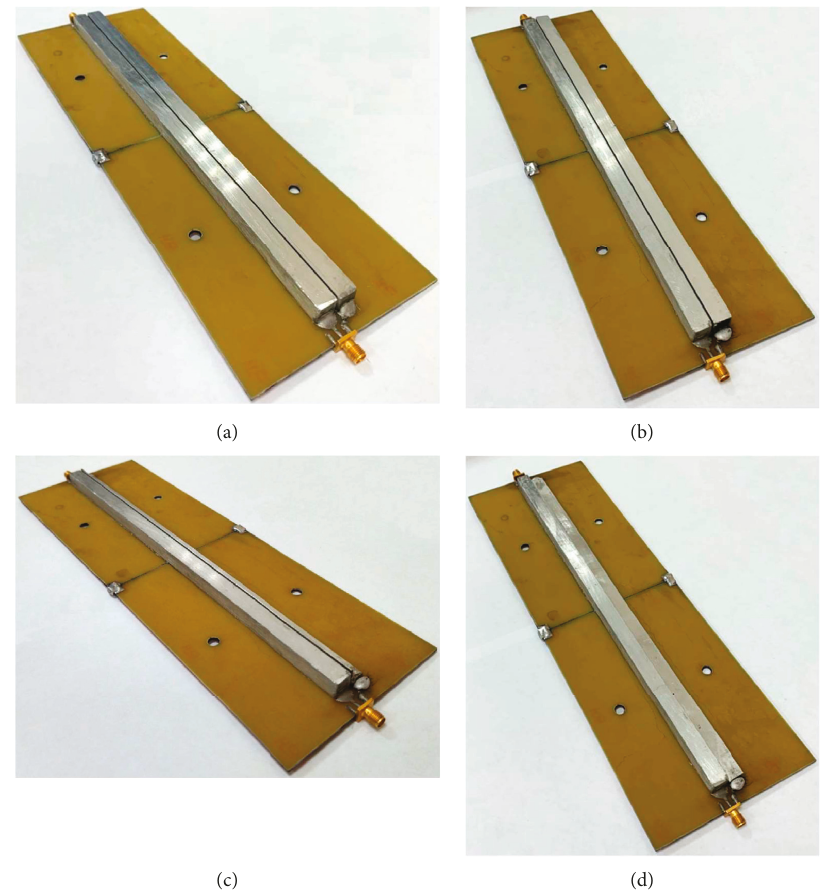
Figure 3: MF with a passive conductor: (a) solid, (b) hollow, (c) corner, and (d) thin.